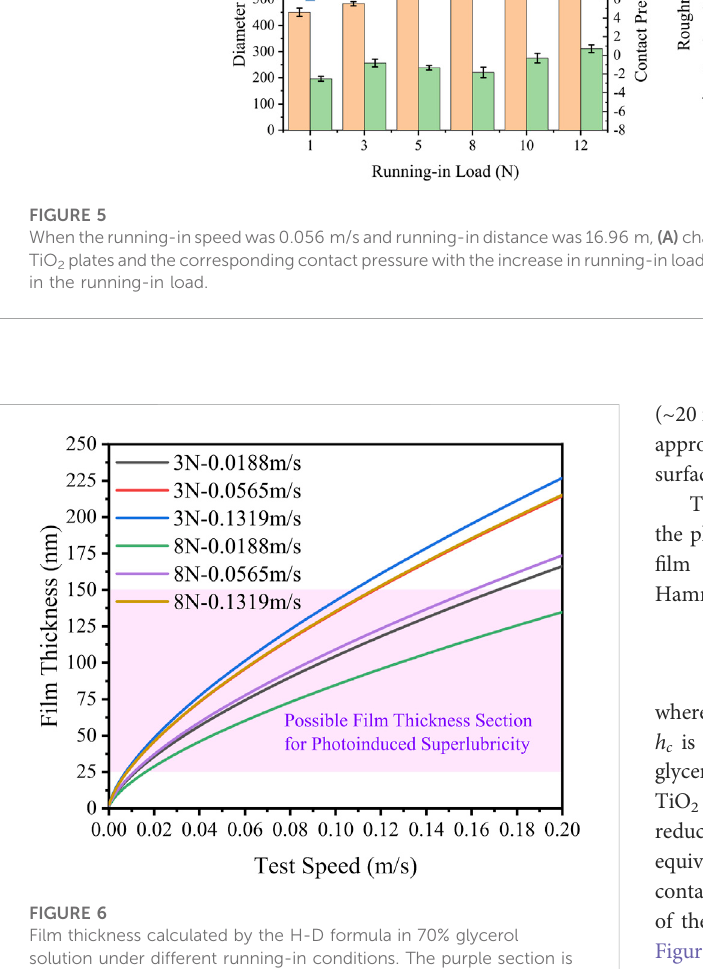
Figure 5B, the roughness on TiO 2 plates decreased to 55 nm and then rose to 99 nm with the increase in the running-in load. However, the roughness on Si 3 N 4 showed no apparent difference when the loads